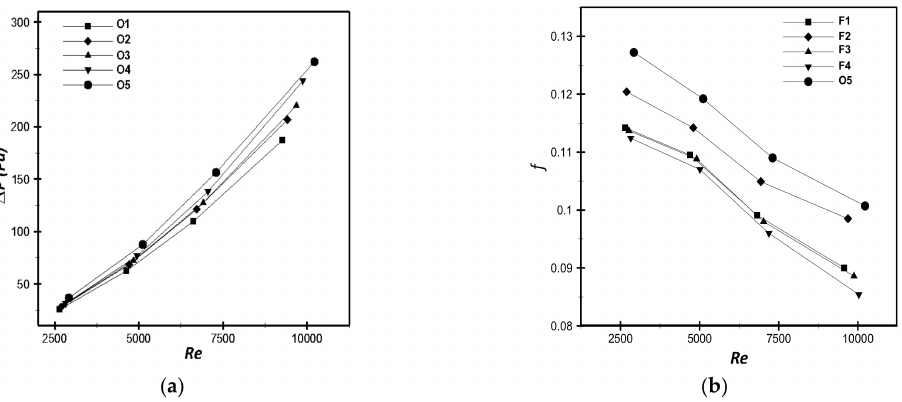
Figure 11. Comparison of flat tube shapes at varying Reynolds numbers: ( a ) Pressure drop and ( b ) friction